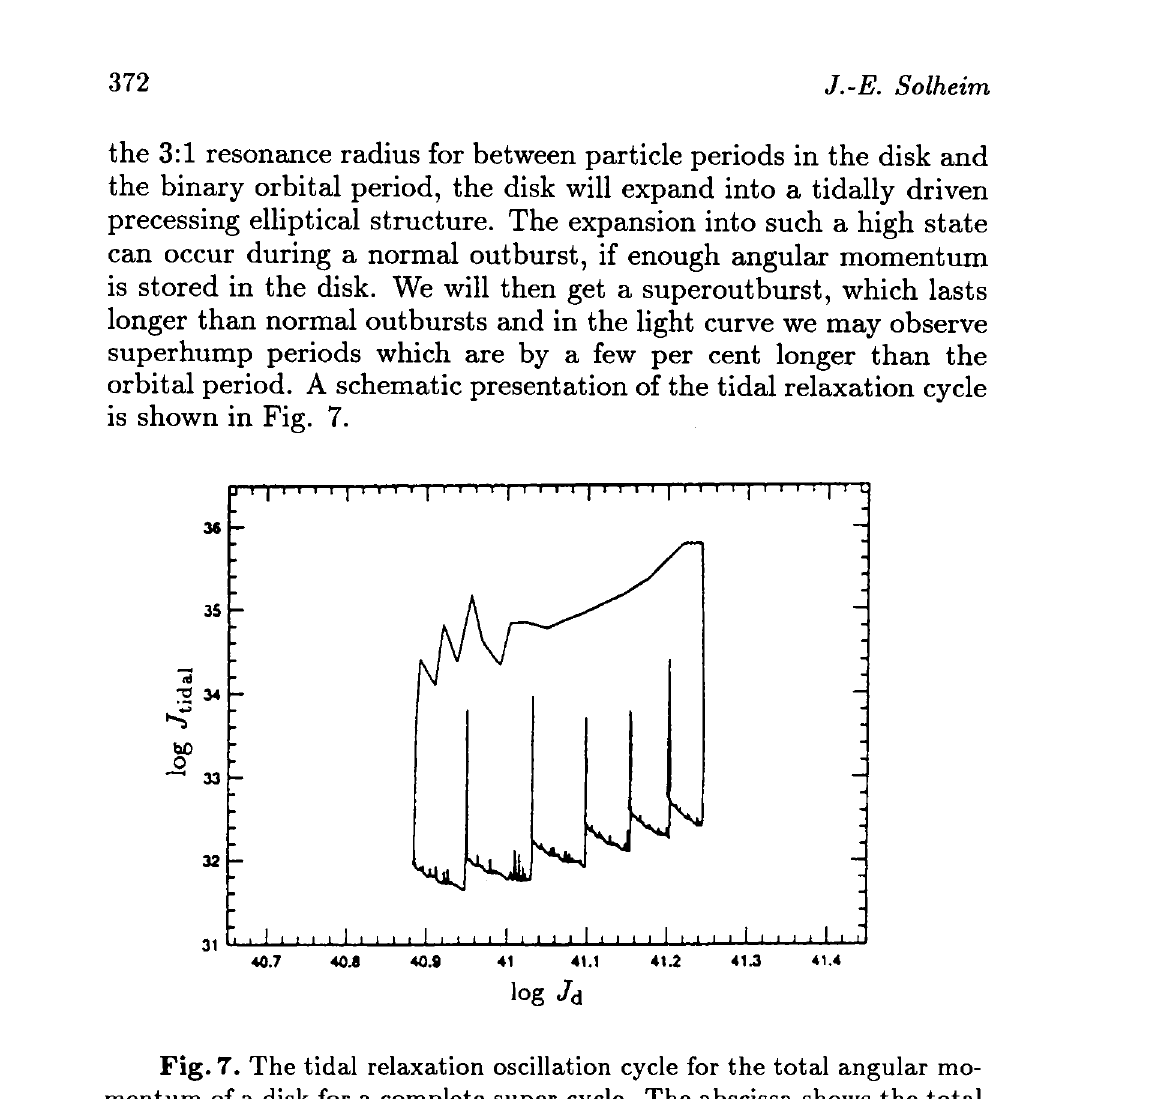
Fig. 7. The tidal relaxation oscillation cycle for the total angular mo- mentum of a disk for a complete super-cycle. The abscissa shows the total angular momentum of the disk and the ordinate is the tidal torque. The spikes represent normal outbursts which are not strong enough to make the disk expansion beyond the tidal instability limit (after Ichikawa et al.